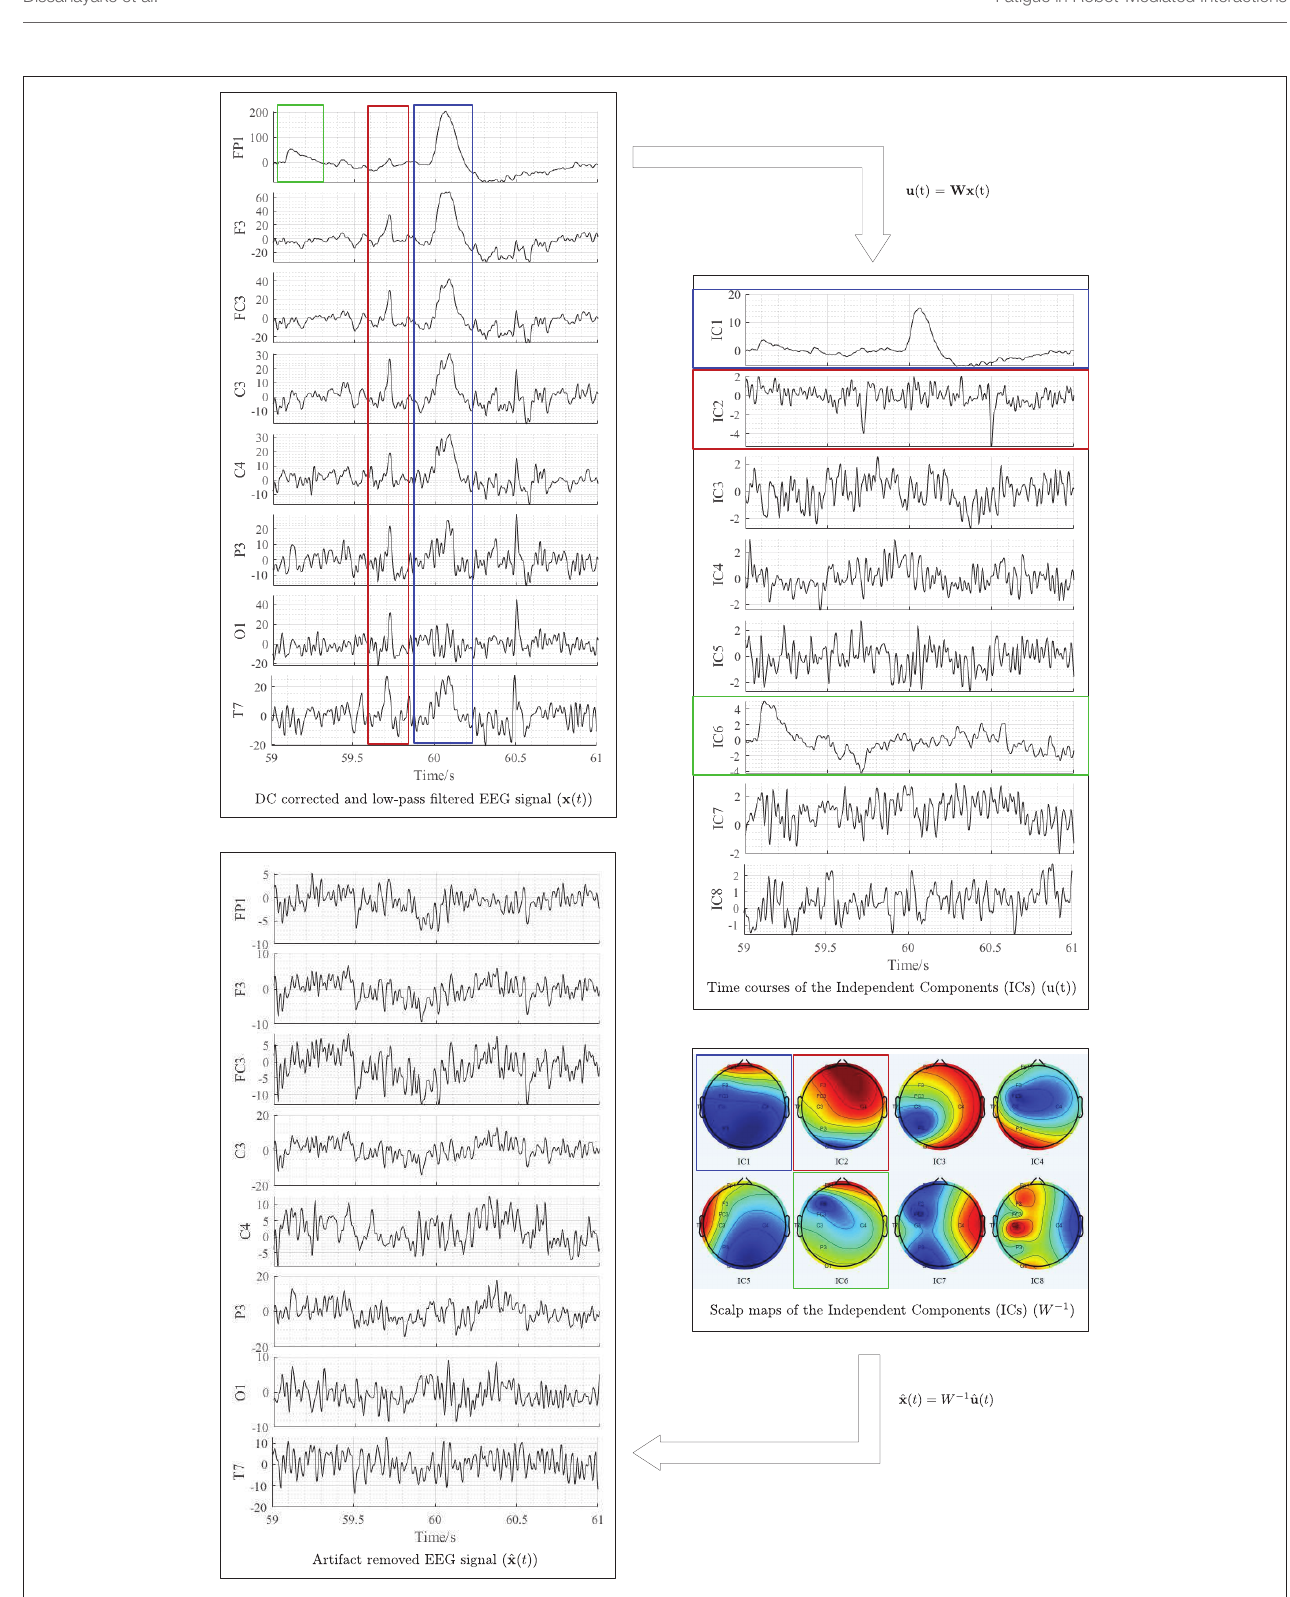
FIGURE 5 | Illustration of EEG artifactual components identification using ICA for one participant. The red, blue, and green rectangles correspond to cardiac activity, eye blink, and eye movement artifacts, respectively. All data were referenced to the right earlobe (A2).